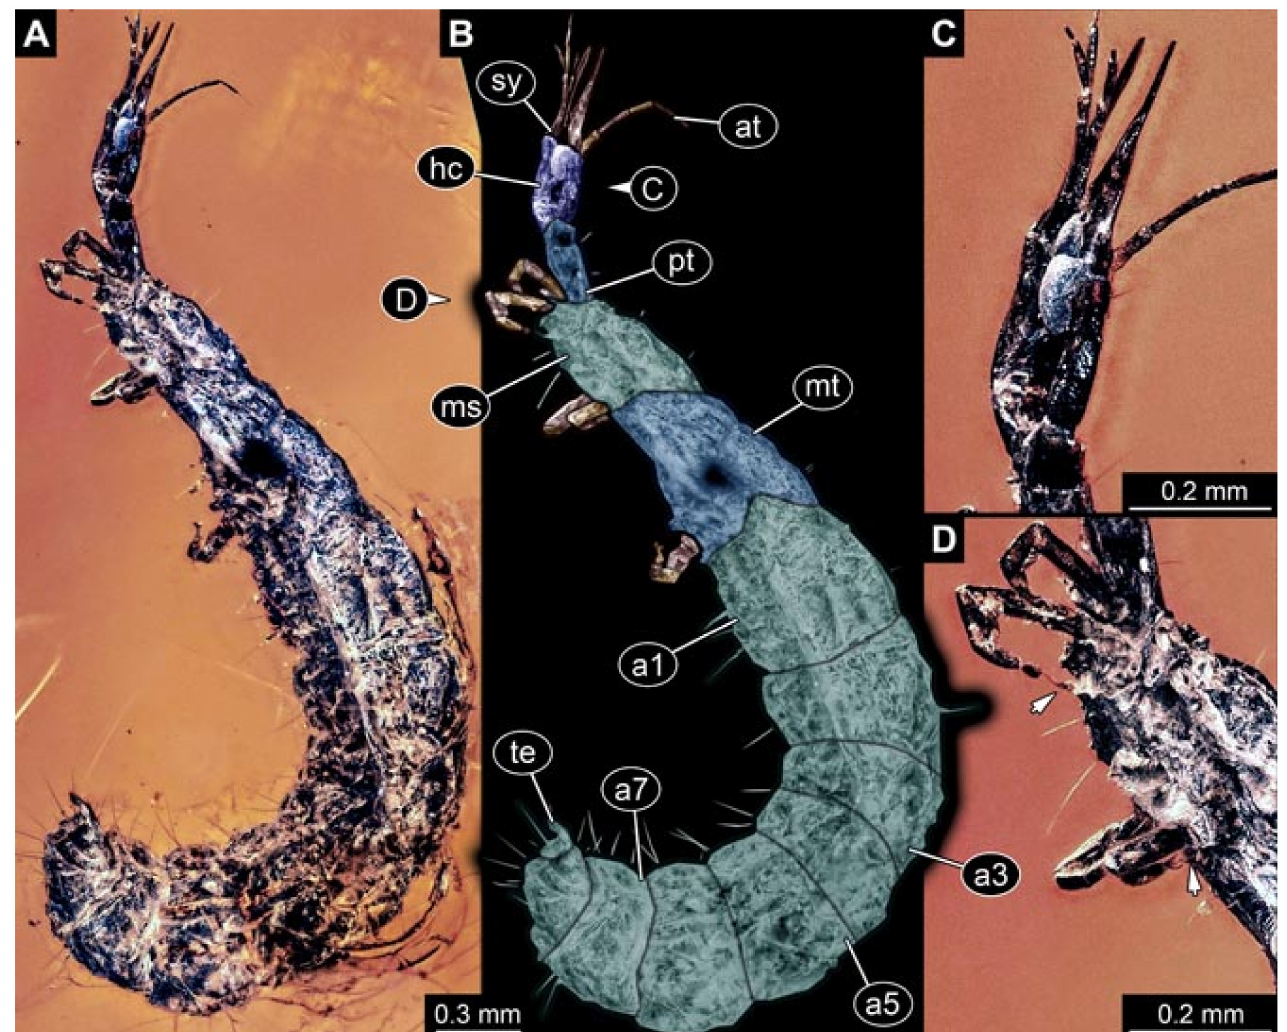
Figure 12. Specimen 5833 (CJW F 3197); Myanmar amber. ( A ) Lateral view slightly curved. ( B ) Lateral view slightly curved, colour-marked. ( C ) Close-up of head in dorso-lateral view. ( D ) Close-up of trunk appendages with empodia (arrows) in ventro-lateral view. Abbreviations: a1–a7 = abdomen segments 1–7; at = antenna; hc = head capsule; ms = mesothorax; mt = metathorax; pt = prothorax; sy = stylet; te = trunk